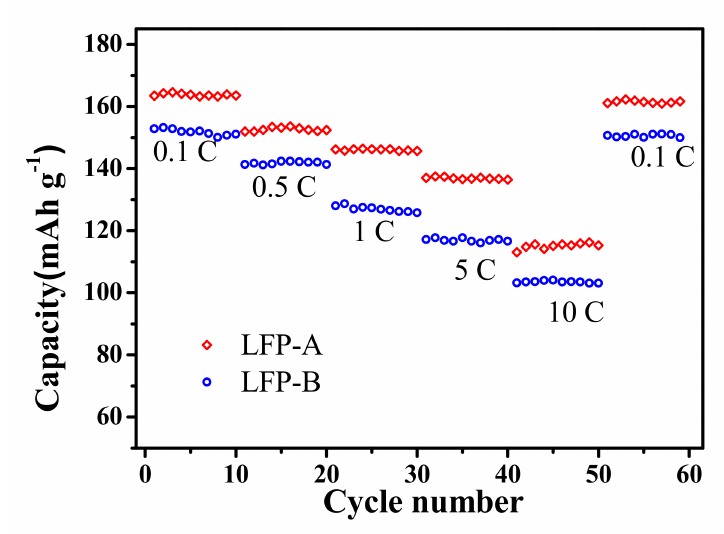
Figure 7. Cyclability of discharge capacities at various charge rates.